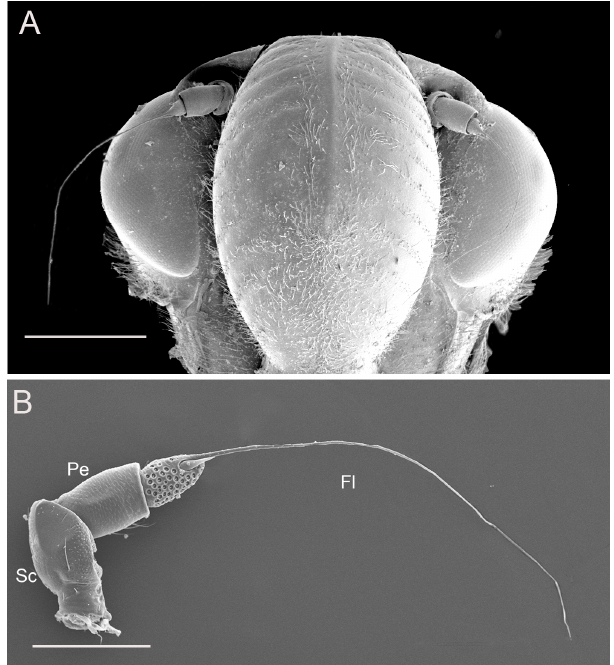
Figure 1. Scanning electron microscopy (SEM) images of Callitettix versicolor (Fabricius) female antenna. ( A ) Fronto-ventral view of the head capsule showing the insertion of the antennae and their relative position; ( B ) General view of the antenna showing the scape (Sc), the pedicel (Pe) and the flagellum (Fl). Scale bars: A = 500 μm; B = 250 μm.